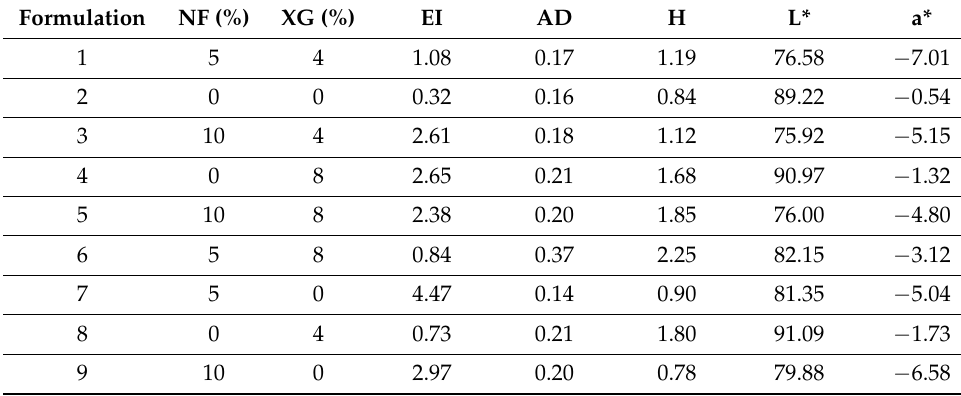
Table 5. Results of the analysis of snacks made from native starch. Formulation